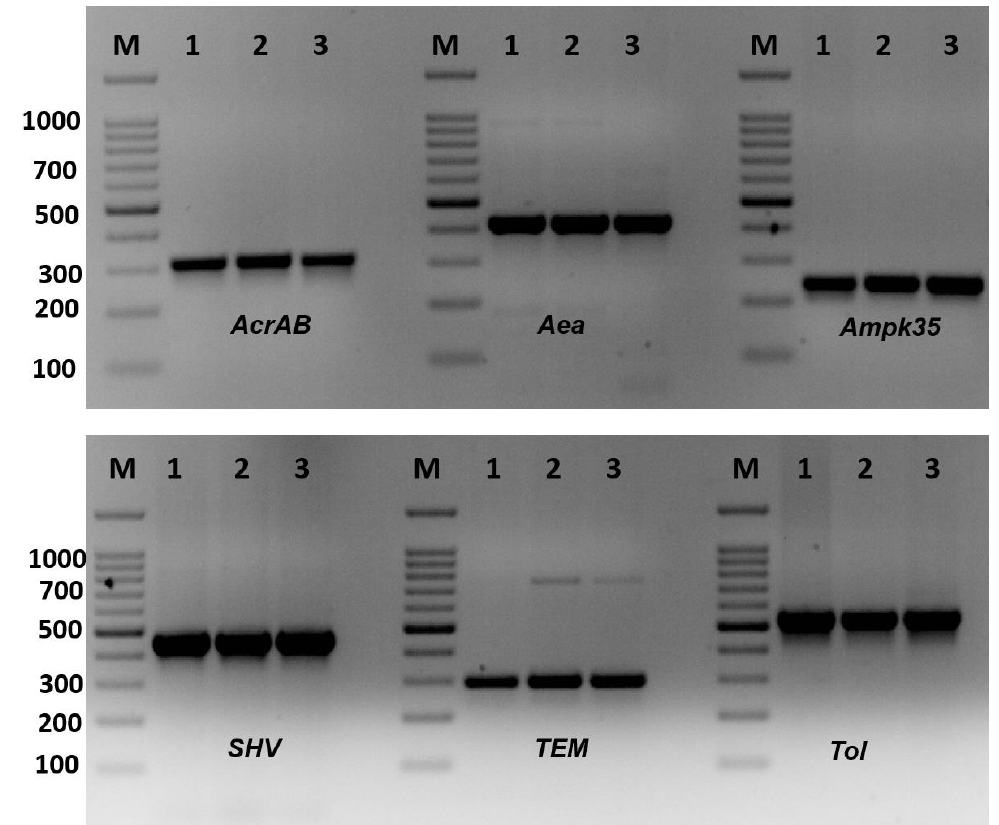
Figure 2. Amplification of virulence genes of Klebsiella pneumoniae isolates by single PCR. Amplifi- cation of AcrAB gene (312 bp), amplification of Aea gene (410 bp), amplification of Ompk35 gene (241 bp), amplification of SHV gene (436 bp), amplification of TEM gene (295), and amplification of Tol genes (527). M: 100 bp DNA ladder, 1–3: some positive isolates. Table 4. Virulence genes ( AcrAB , TolC , mdtk , Ompk35 , FimH , RmpA , Aea , SHVM , TEM , K1 , and K2 ) in Klebsiella pneumoniae isolates.